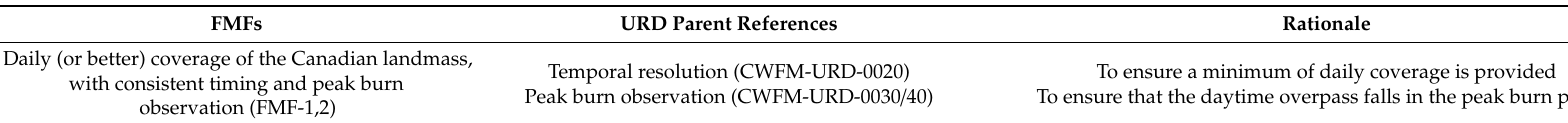
Table 3. Primary relationships (not exhaustive) between Fire Management Functionalities (FMFs) and User Requirements from the User Requirements Document [49] (URD). FRP refers to Fire Radiative Power (e.g., [32]).